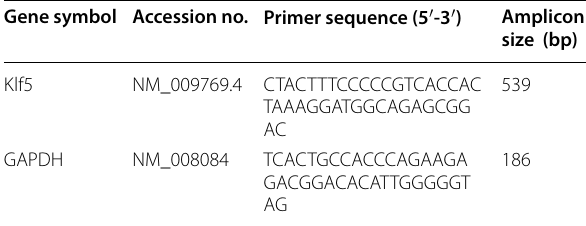
Table 1 Primers for Klf5 and